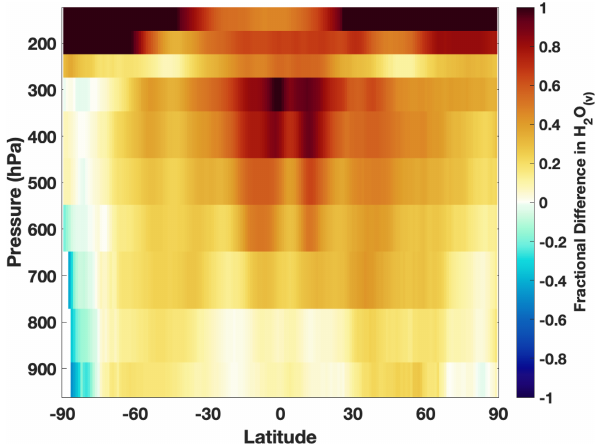
Figure 4. The fractional difference in zonal mean H 2 O ( v ) between MERRA-2 GMI and AIRS for the different AIRS pressure layers for DJF. Positive numbers indicate a high bias in the